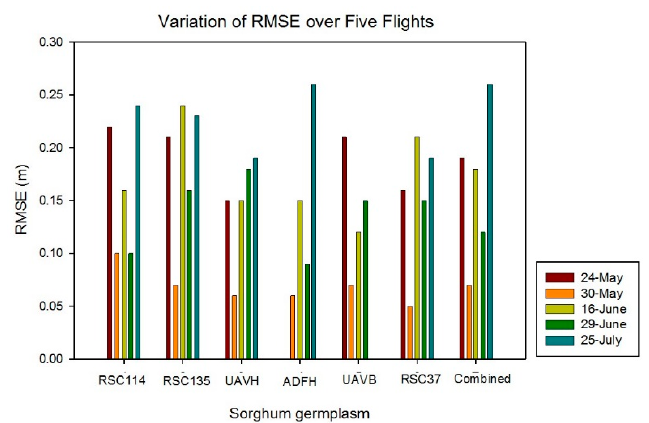
Figure 16. Variation of RMSE for sorghum height estimate over five flights.